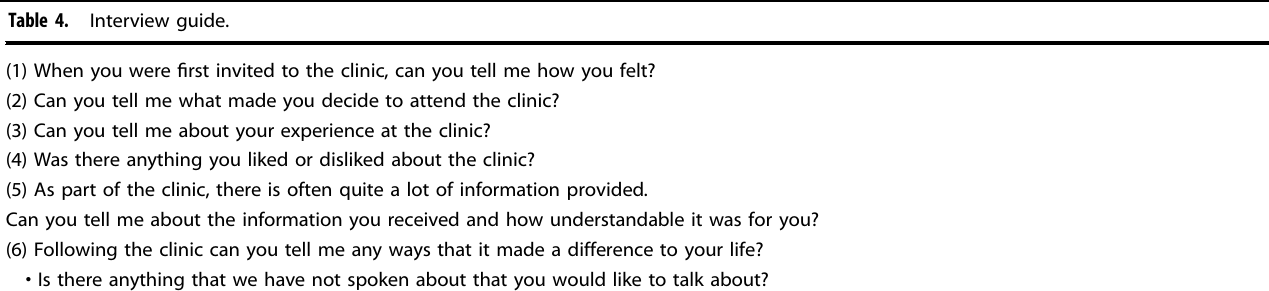
Table 4. Interview